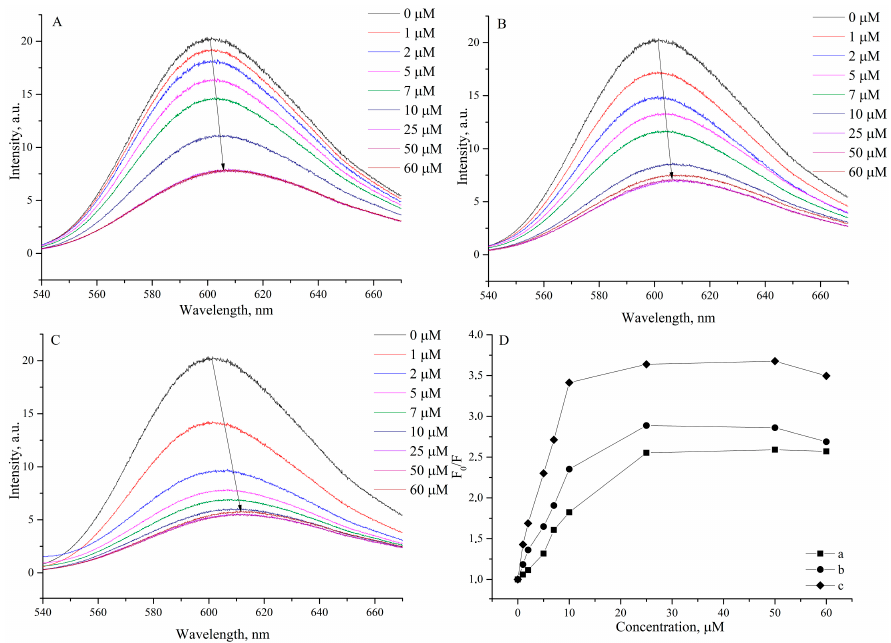
Figure 4. Emission spectra of the EthBr–CT-DNA system in the absence and presence of various concentrations of the macrocycles ( A )— 5 , ( B )— 6 , ( C )— 7 in 10 mM Tris/50 mM NaCl buffer solution with pH 7.4. [CT DNA] = 50 µM, [EthBr] = 10 µM, λ ex = 520 nm. ( D )—plot of F 0 /F versus [macrocycle], a— 5 , b— 6, c— 7 .